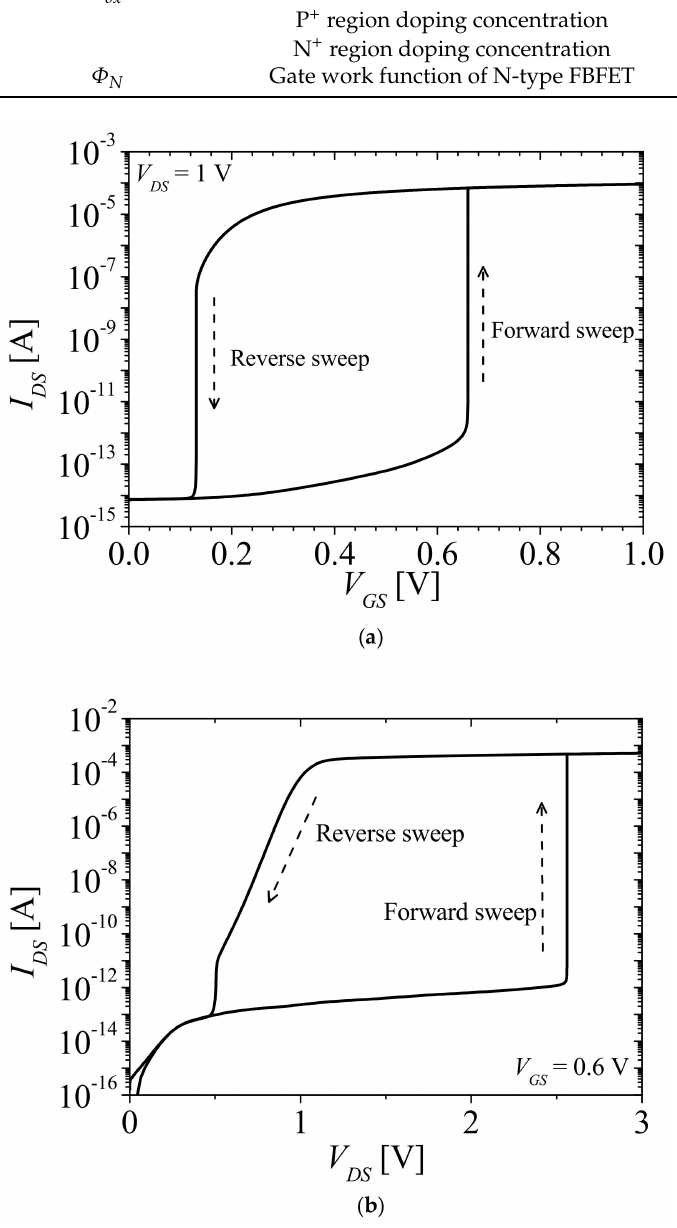
Figure 2. ( a ) I DS -V GS characteristics at V DS = 1 V; ( b ) I DS -V DS characteristics at V GS = 0.6